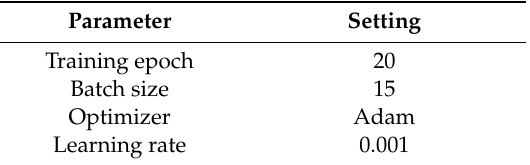
Table 1. Parameters of the Convolution Neural Network (CNN) model used in this study.